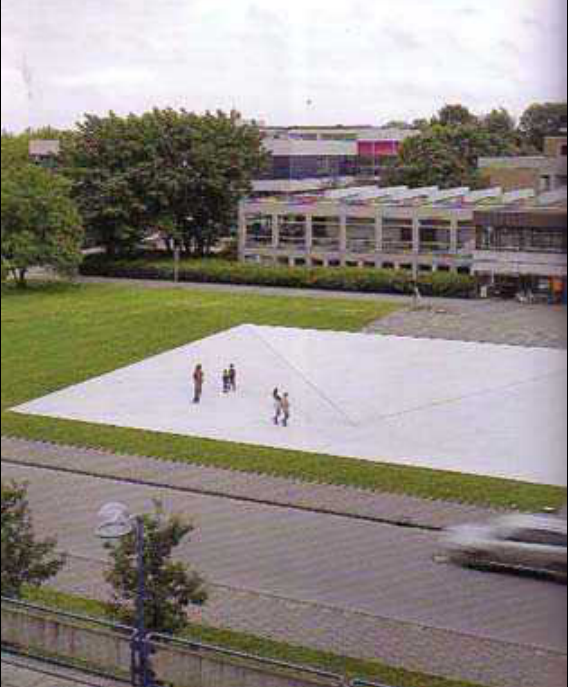
Fig. 13. Square Depression by bruce Nauman, Muenster,